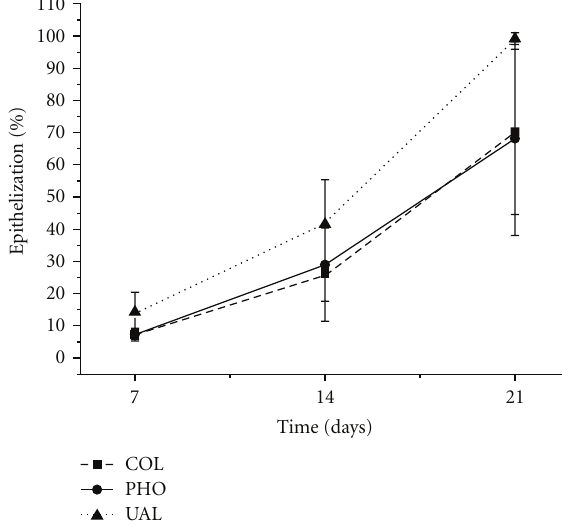
Figure 3: Epithelization of the burn wound